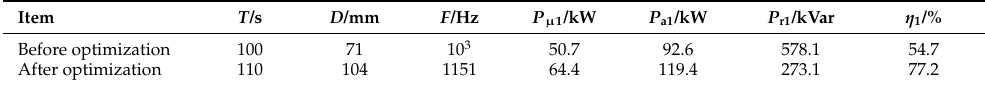
Table 2. Comparison of medium-frequency induction furnace parameters in the non-magnetic